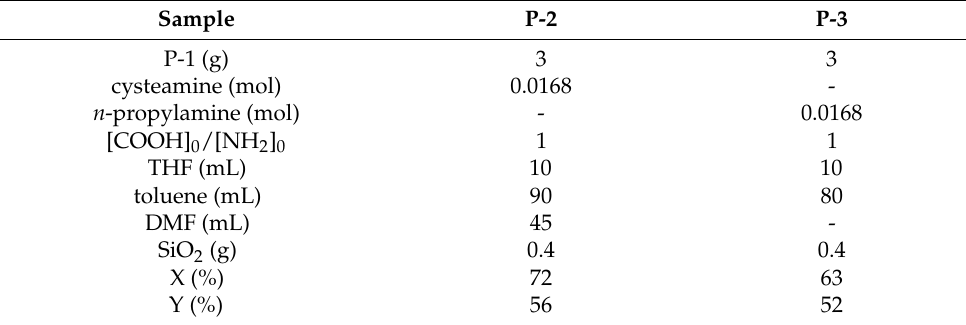
Table 3. Composition of reaction mixtures during the synthesis of P-2 and